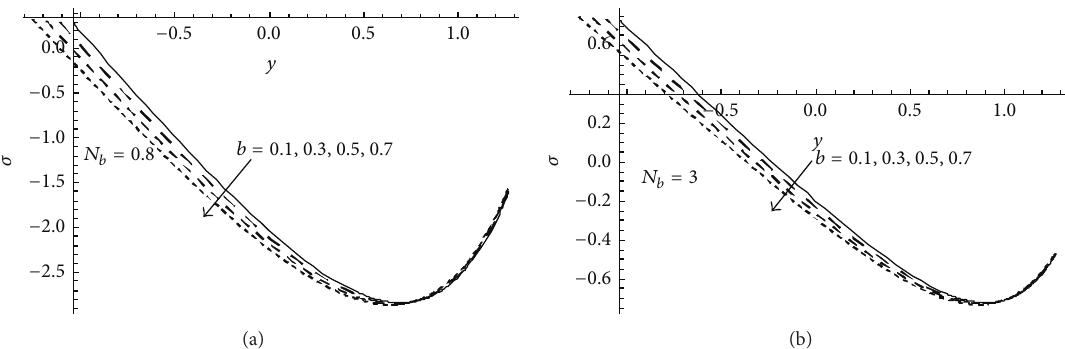
Figure 7: Variation of nanoparticle concentration at different values of 𝑏 when 𝑁 𝑡 = 5 , 𝑑 = 1 , 𝑎 = 0.5 , 𝑥 = 1 , 𝜙 = 0.2 , 𝛾 = 0.3 , and 𝛾 1 = 0.3 for (a) 𝑁 𝑏 = 0.8 and (b) 𝑁 𝑏 = 3 .